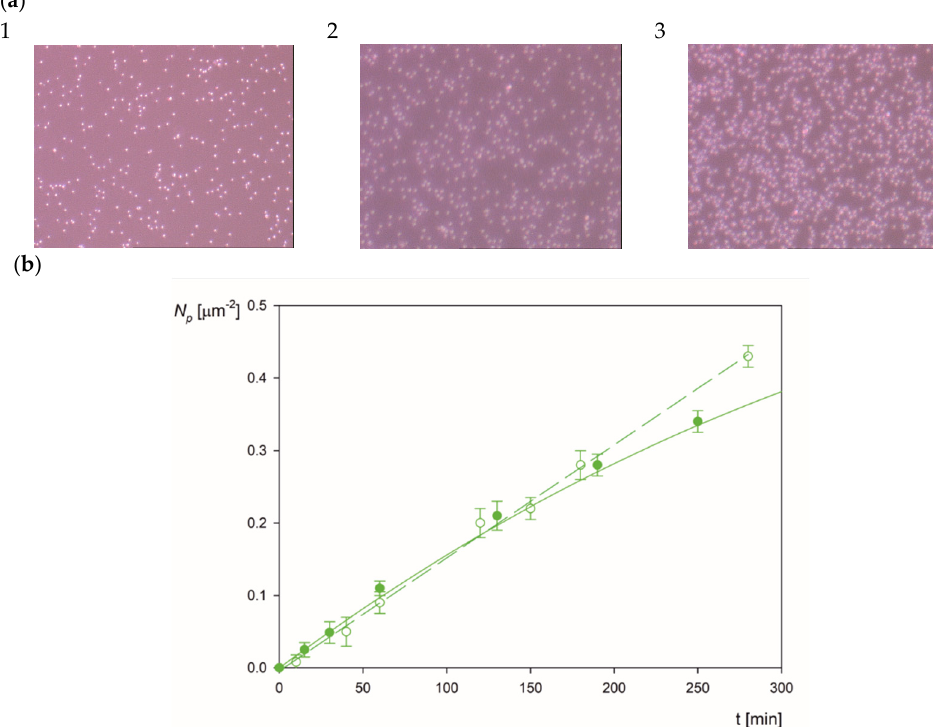
Figure 5. Part ( a ). Micrographs of the LSFi particles on mica for various surface concentrations equal to: 1—0.05 µm − 2 (scale 135 µm × 100 µm), 2—0.2 µm − 2 (scale 59 µm × 45 µm), 3—0.4 µm − 2 (scale 59 µm × 45 µm) Part ( b ). The kinetics of LSFi particle deposition at mica in the OBIJ flow cell, shown as the dependence of the surface concentration on the deposition time, particle bulk concentration 100 mg L − 1 , pH 3.5, 0.001 mol L − 1 NaCl, flow rate 2.5 × 10 − 3 cm 3 s − 1 . The hollow points show the reference results acquired by in situ optical microscopy for positively charged LA microparticles, and the full points represent the results for LSFi particles. The solid line shows the theoretical results derived from the convective diffusion model with the RSA blocking function, and the dashed line represents the linear deposition regime.